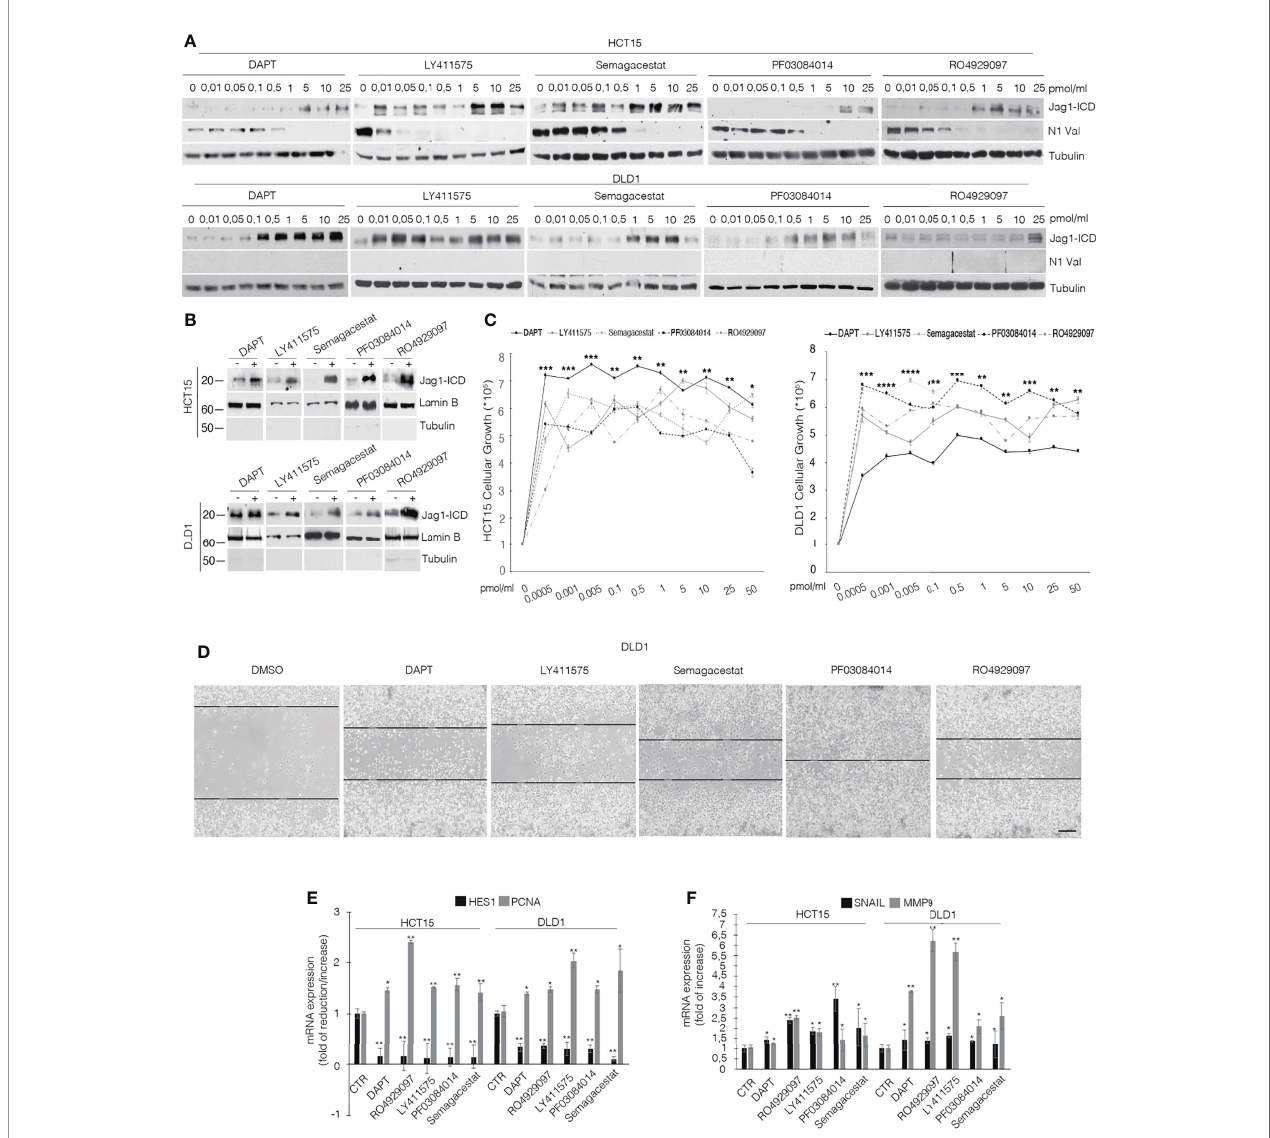
FIGURE 1 | GSIs induce Jagged1 cleavage in Jagged1/KRAS CRC cell lines and induce proliferation and EMT. (A) HCT15 and DLD1 cell lines were treated with several GSI compounds (DAPT, LY411575, Semagacestat, PF03084014, and RO4929097) or vehicle alone (DMSO) with the indicated doses (pmol/ m l) for 24 h. Whole-cell extracts (WCEs) were subjected to Western blot assay, using indicated antibodies against the Jagged1-intracellular domain (Jag1-ICD) and active Notch1 Valin 1744 (N1Val). Tubulin was used as loading control. (B) The subcellular nuclear lysates from HCT15 and DLD1 cells were collected after 48 h of treatment with different GSIs at 10 pmol/ m l and immunoblotted as indicated. Protein levels were normalized using Lamin B and Tubulin, as nuclear and cytoplasmatic control, respectively. (C) HCT15 and DLD1 cells were treated with increasing doses (pmol/ m l) of different GSIs. After 24 h, trypan blue viable cell count was performed to determine the growth rate. All data are representative of at least three independent experiments, each in triplicate. * p < 0.05; ** p < 0.05; *** p < 0.005; **** p < 0.0005 (ANOVA test). (D) Representative area for wound-healing assay of DLD1 cells after 48 h of scratch, treated with several GSIs. Scale bar, 200 m m. (E) Hes1 and PCNA mRNA expression levels were determined by qRT-PCR from GSI-treated cells and normalized relative to human GAPDH . Graph was depicted as fold change compared with DMSO-treated cells. Data were presented as mean ± SD. (F) qRT-PCR analysis of mmp9 and snail mRNA from CRC cells, treated with different GSIs, was represented as fold changes ± SD after intrasample normalization to the level of GAPDH. All data are representative of at least three independent experiments, each in triplicate. * p < 0.05; ** p < 0.05; *** p < 0.005 (Student ’ s t-